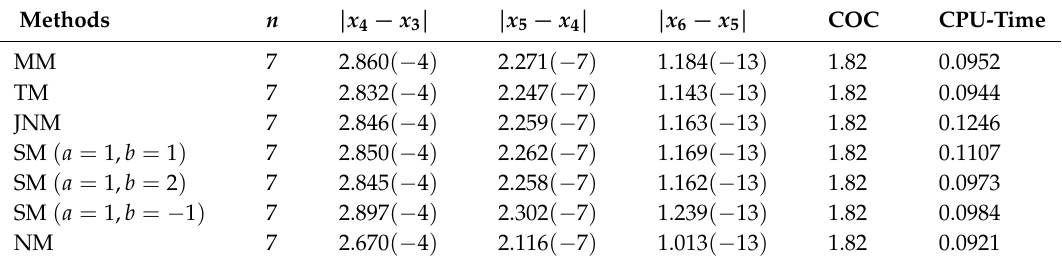
Table 1. Comparison of performance of methods for function f 1 ( x ) , taking x 0 = 0.5, x 1 = − 0.3, x 2 = 0.1.